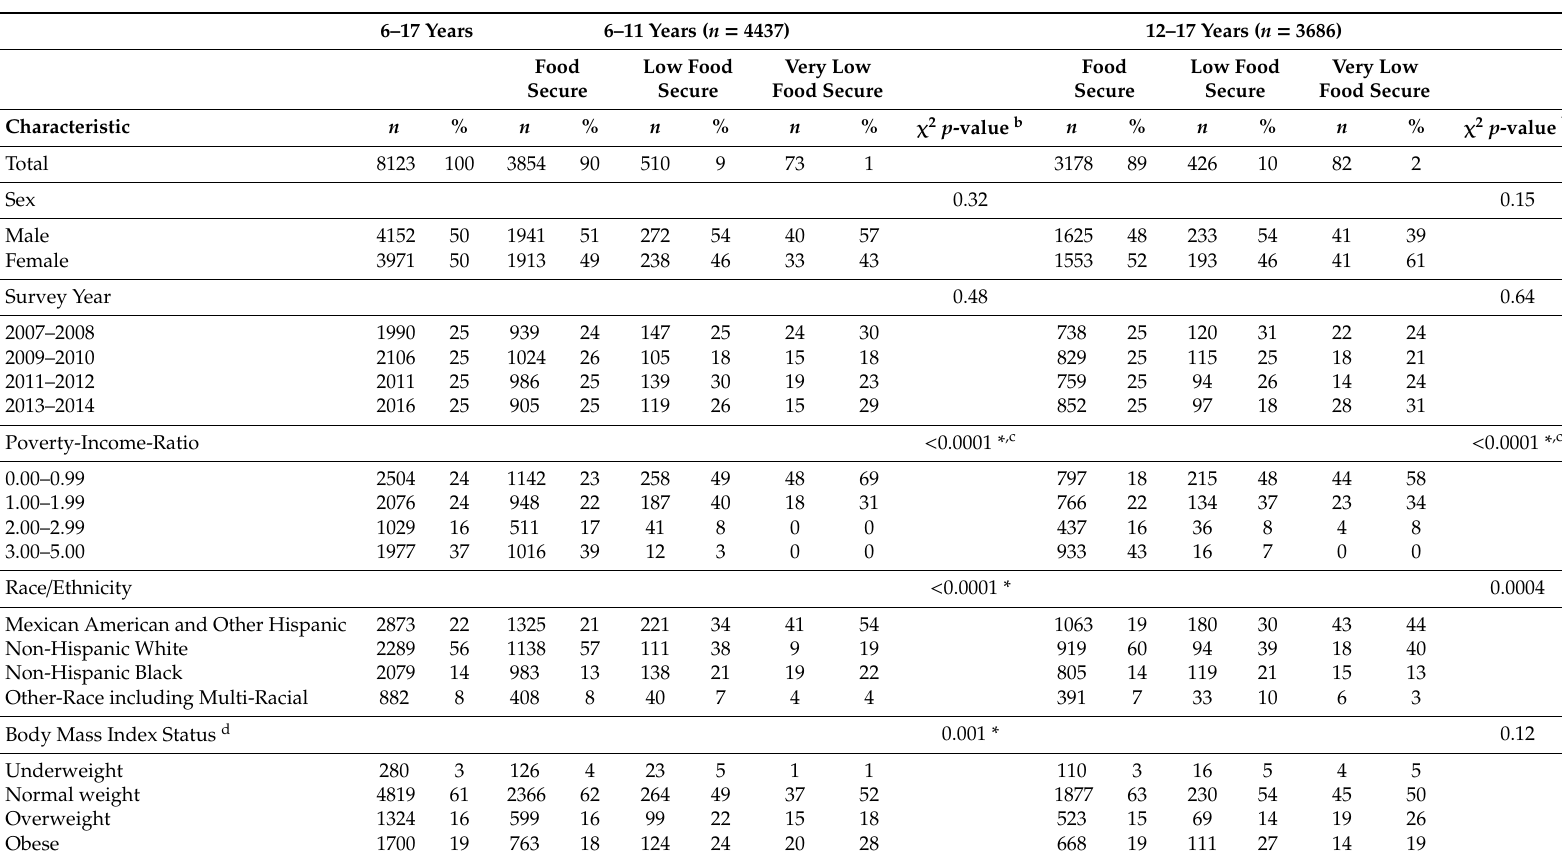
Table 1. Characteristics of food secure, low and very low food secure U.S. children and adolescents ages 6–17 years using the National Health and Nutrition Examination Survey 2007–2014 a